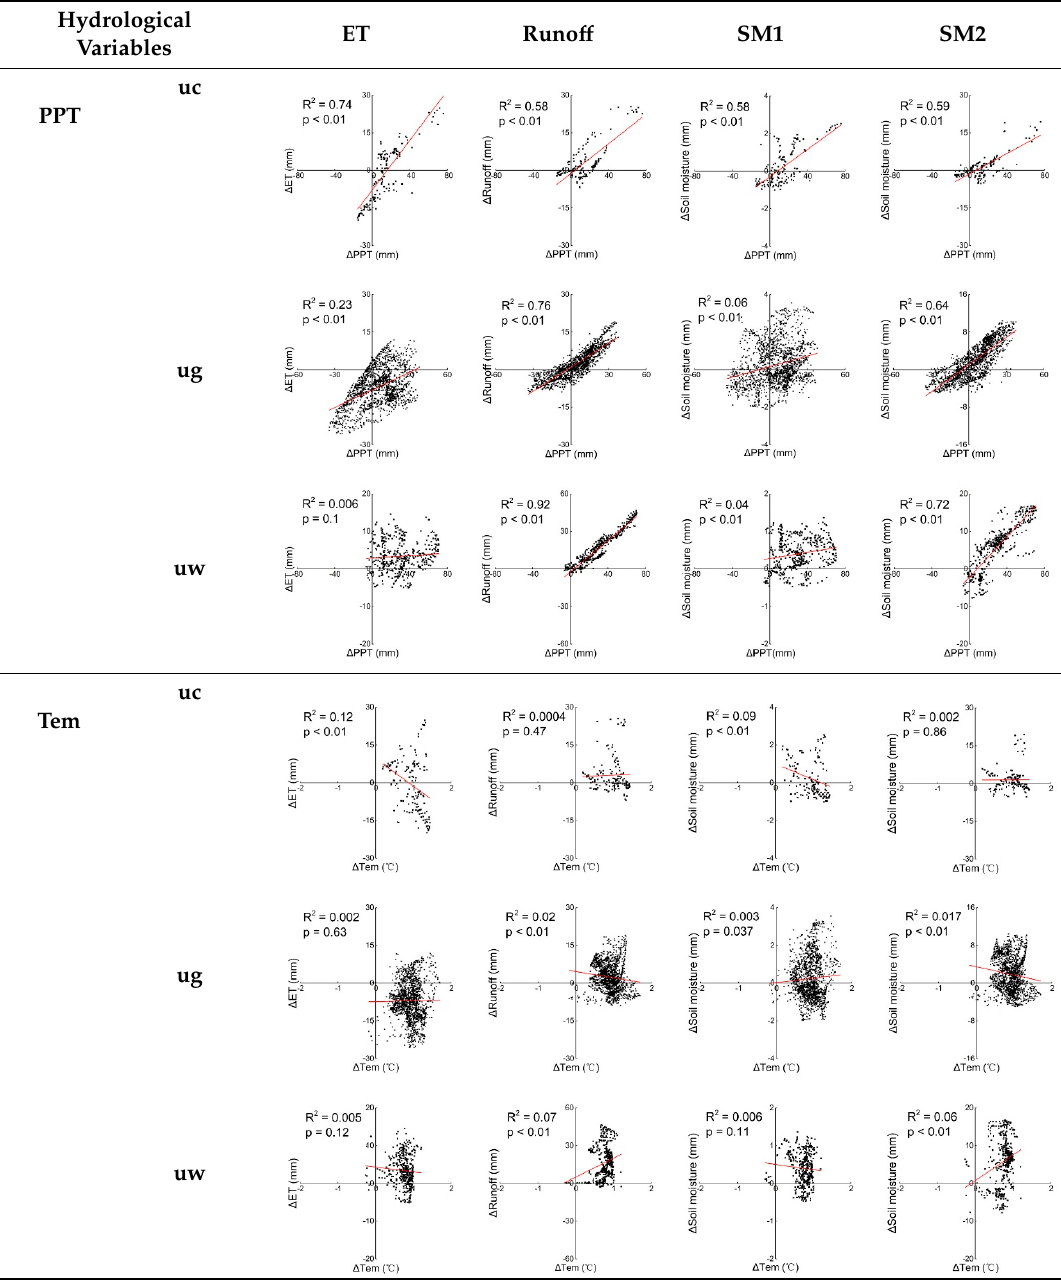
Table 3. The driving effects of meteorological variables on variations in the four HVs of three vegetation types.